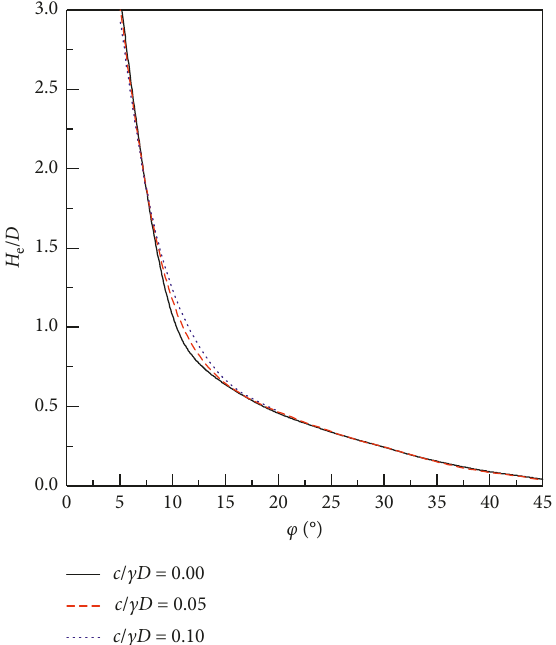
Figure 9: The critical heights of the tunnel face failures.